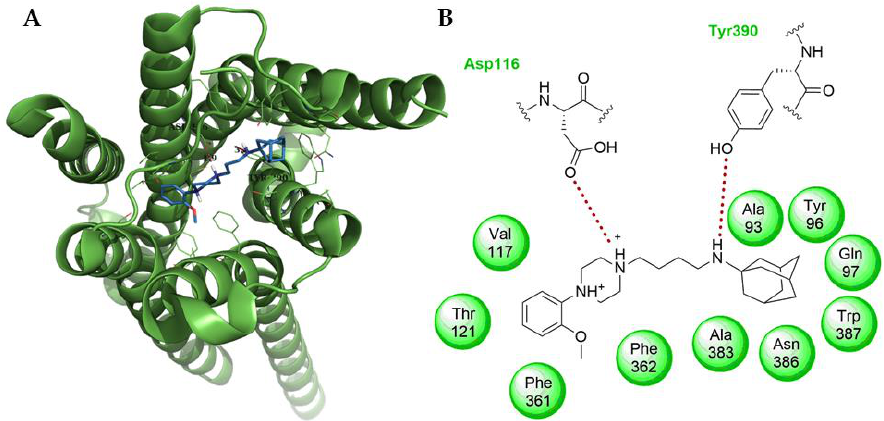
Figure 3. ( A ) Green cartoon representation of the 5-HT 1A receptor with the presence of ( 8 ) at lowest scoring function binding mode as obtained from the software OpenEye in blue colored sticks, ( B ) 2D representation of ( 8 ) binding network forming as obtained from OpenEye software. Brick red dashed lines represent HB between receptor and ( 8 ).